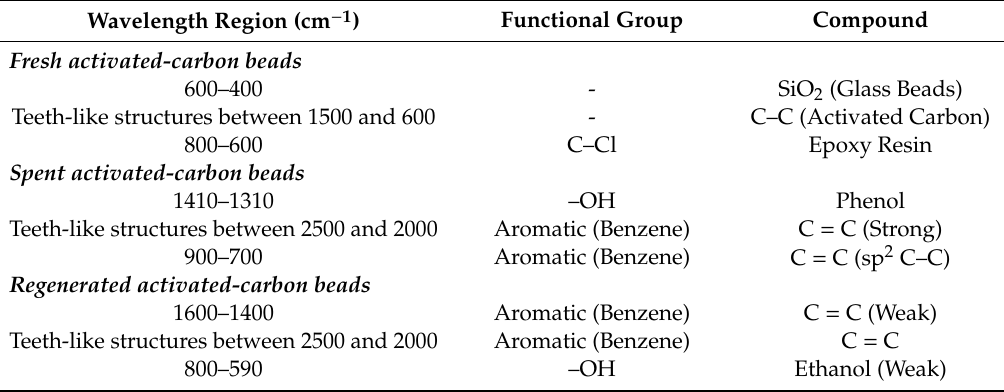
Figure 8. FTIRanalysisoftheadsorbent: ( a )beforeadsorption; ( b )afteradsorption; and( c )afterdesorption. Table 4. FTIR functional group analysis for the activated-carbon